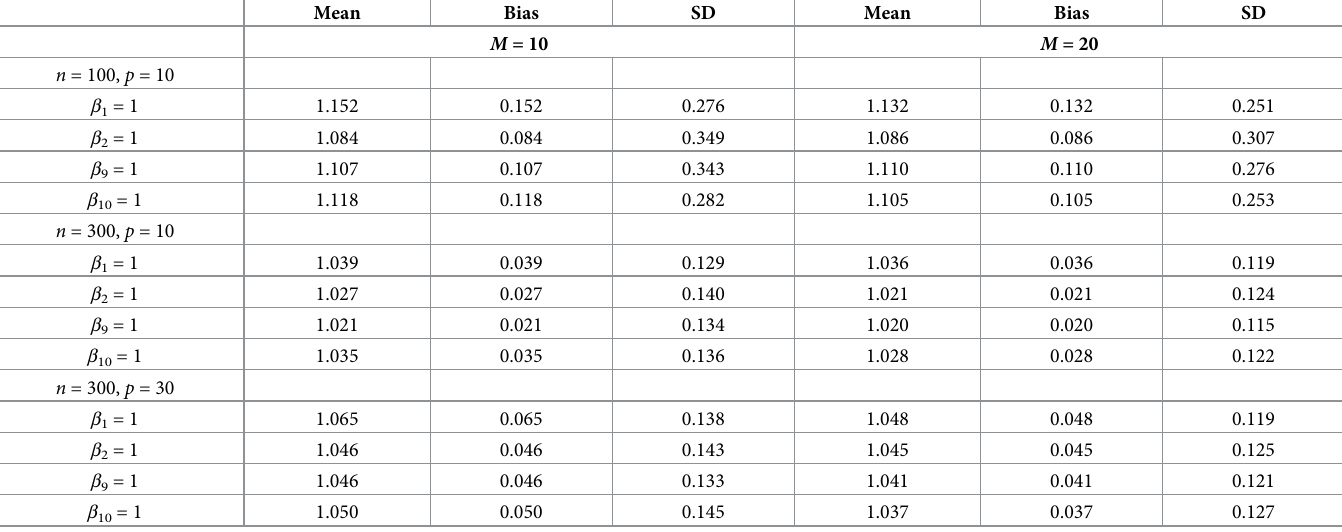
Table 3. Simulation result of appIC sparse estimation with b 0 = 1 and baseline cumulative hazards function Λ 0 ( t ) = t